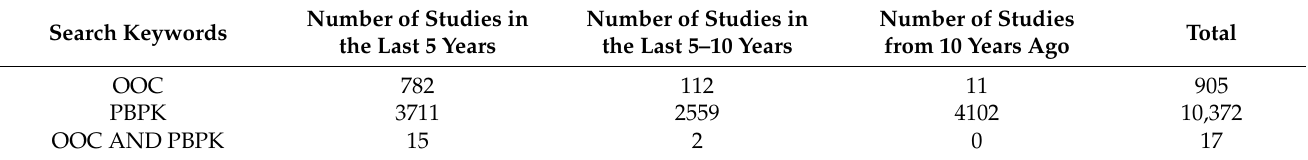
Table 3. Number of studies regarding OOC and PBPK in